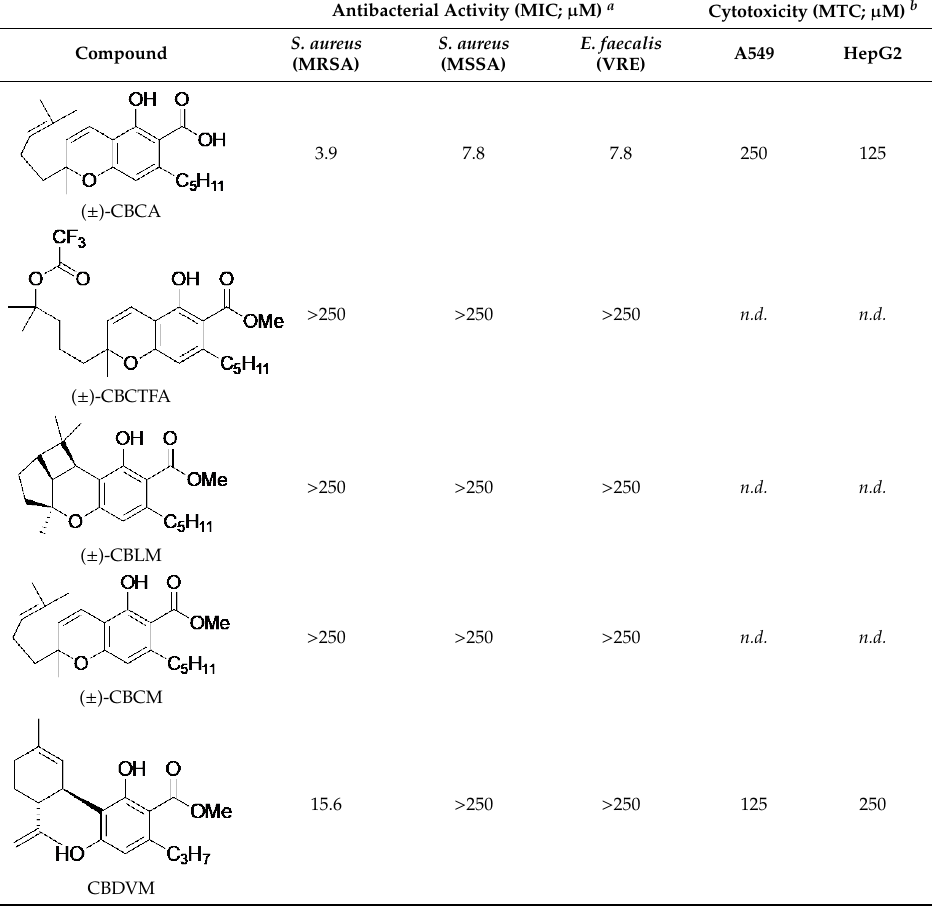
Table 1. Antibacterial activity of phytocannabinoids and related compounds against clinically relevant gram-positive bacteria.